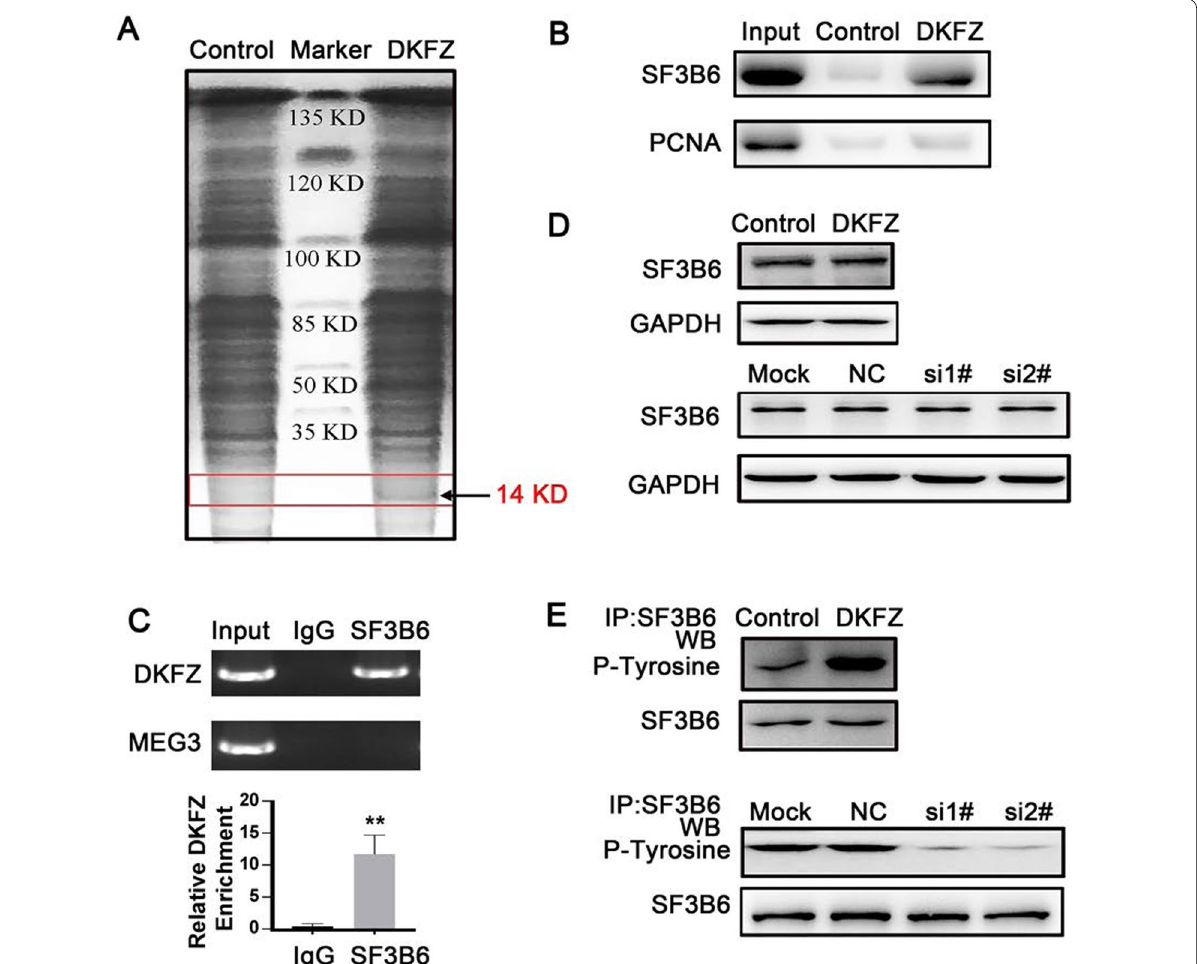
Fig. 5 SF3B6 serves as a DKFZp434J0226 (DKFZ)-binding protein. A RNA pull-down assay performed in the HEK293T cell lysates with biotin-labeled oligos. After pull-down, proteins were subjected to SDS-PAGE and stained by Coomassie brilliant blue. The band indicated by the arrow was subjected to mass spectrometry. B Western blotting analysis determined the specific interaction of sense DKFZ with SF3B6 protein, but not with PCNA protein (negative control). C RNA immunoprecipitation (RIP) of SF3B6 interaction with DKFZ in the HEK293T cells. RNA-protein complexes immunoprecipitated by anti-SF3B6 or control IgG were determined by RT-qPCR using specific primers for DKFZ or MEG3 (negative control). Data are shown as mean SD (n 4); ** P < 0.01. D Western blotting analysis of SF3B6 levels in the indicated DKFZ overexpression AsPC-1 cells or DKFZ ± = knockdown MIAPaCa-2 cells. E Western blotting analysis of SF3B6 phosphorylation levels in the indicated DKFZ overexpression AsPC-1 cells or DKFZ knockdown MIAPaCa-2 cells. For SF3B6 phosphorylation detection, cell lysates were prepared and subjected to immunoprecipitation (IP) with anti-SF3B6 antibody, followed by immunoblotting analysis with the anti-phospho-tyrosine